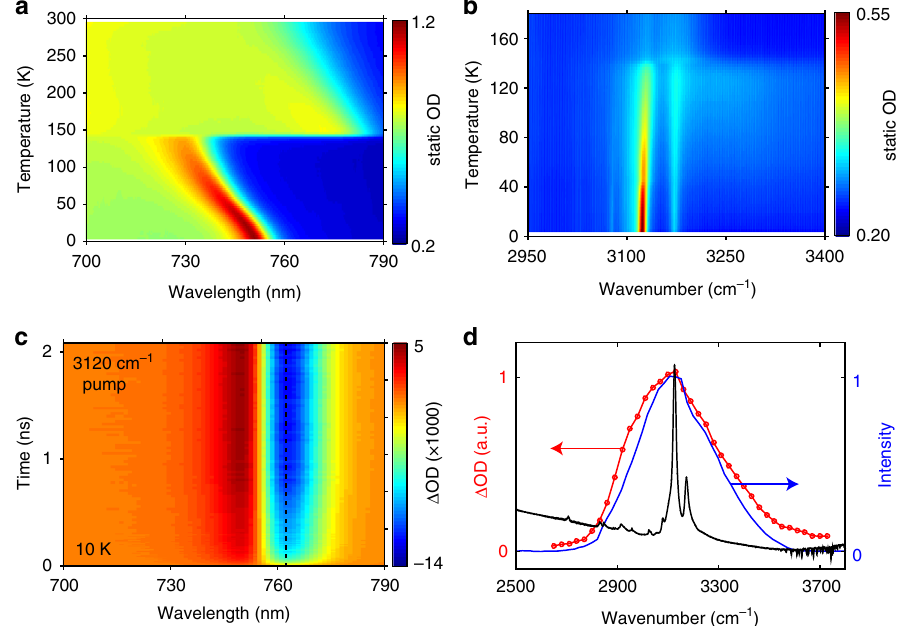
Fig. 1 Static and infrared pump electronic-probe (IPEP) measurements of CH 3 NH 3 PbI 3 . a Static, temperature-dependent absorbance around the bandgap. b Static, temperature-dependent absorbance around the N-H- as vibrational modes. c Δ OD spectral map measured with on-resonance infrared pump (centered at 3120 cm − 1 ) at 10 K. The dashed line shows the wavelength at which the kinetics are extracted (Fig. 2b). d Red: dependence of the magnitude of the strongest bleach signal on the center wavenumber of the pump pulse with a fi xed fl uence (measured at 10 K). Blue: spectral pro fi le of the pump pulse centered at 3120 cm − 1 . Black: static absorbance of CH 3 NH 3 PbI 3 (in arbitrary units) at 80